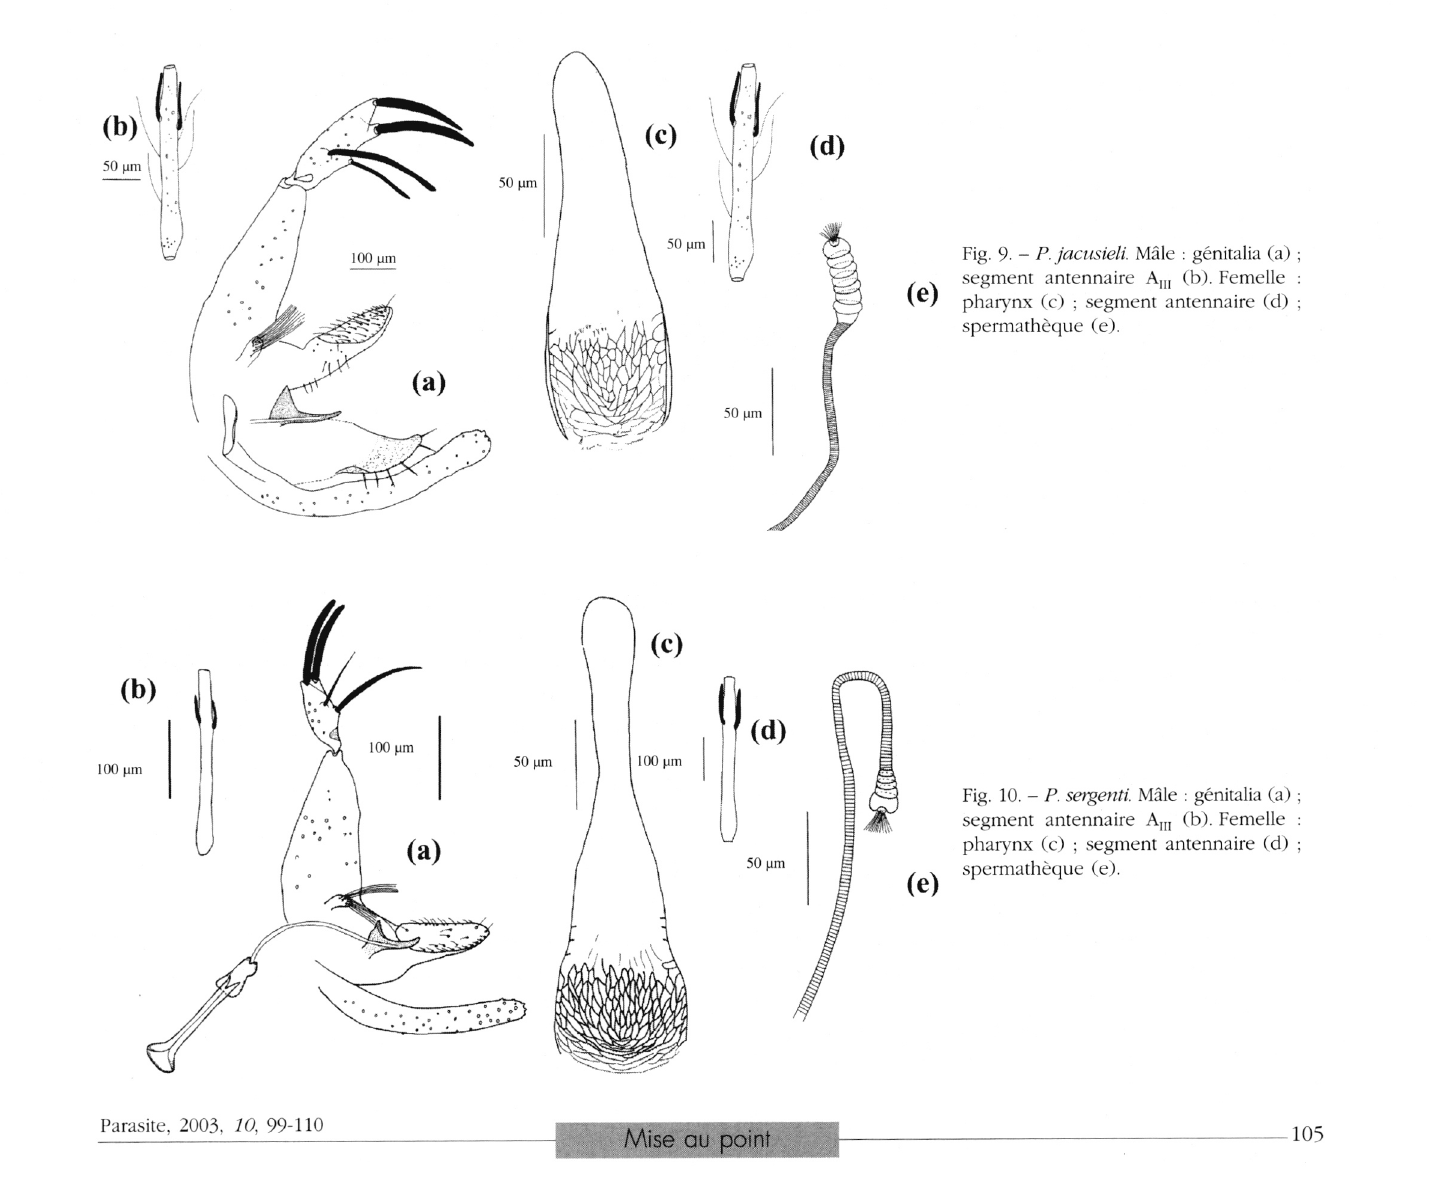
Fig. 9. - P. jacusieli. Mâle : génitalia (a) ; segment antennaire AIII (b). Femelle : pharynx (c) ; segment antennaire (d) ; spermathèque (e).